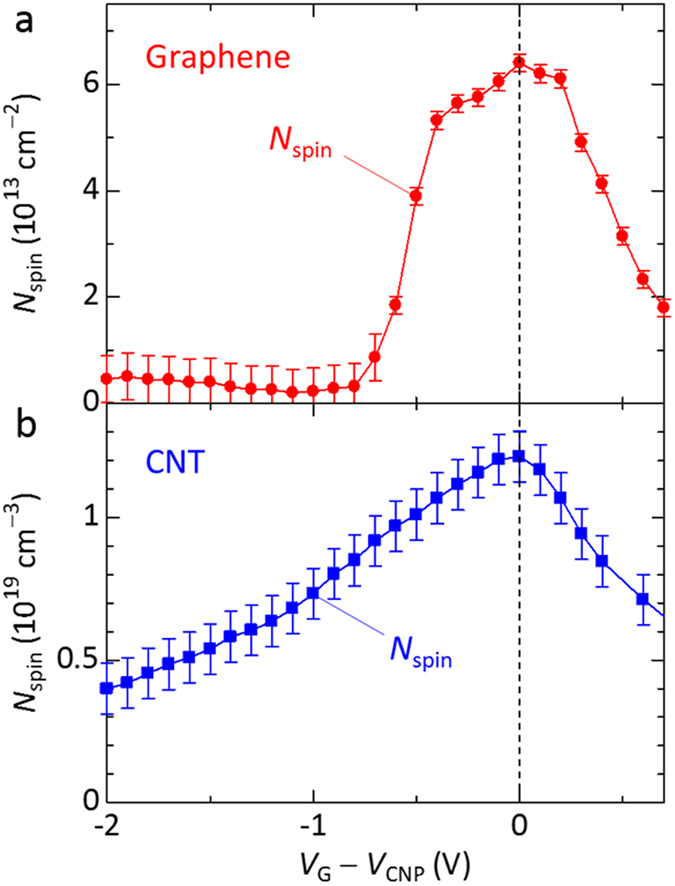
Electrically induced ambipolar spin vanishments due to the atomic vacancies.(a,b) Dependence of the number of spins (Nspin) due to the atomic vacancies in the graphene transistor (a) and in the CNT transistor (b) on VG − VCNP. The data for the CNT transistor are taken from the literature26.